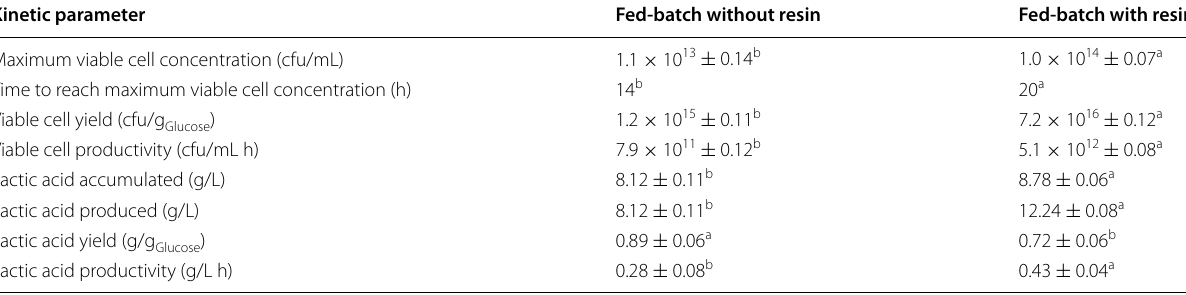
The results presented are the average of triplicate experiments Statistically significant coefficient ( P < 0.05) are expressed as mean a,b Mean values with the different letters are significantly different